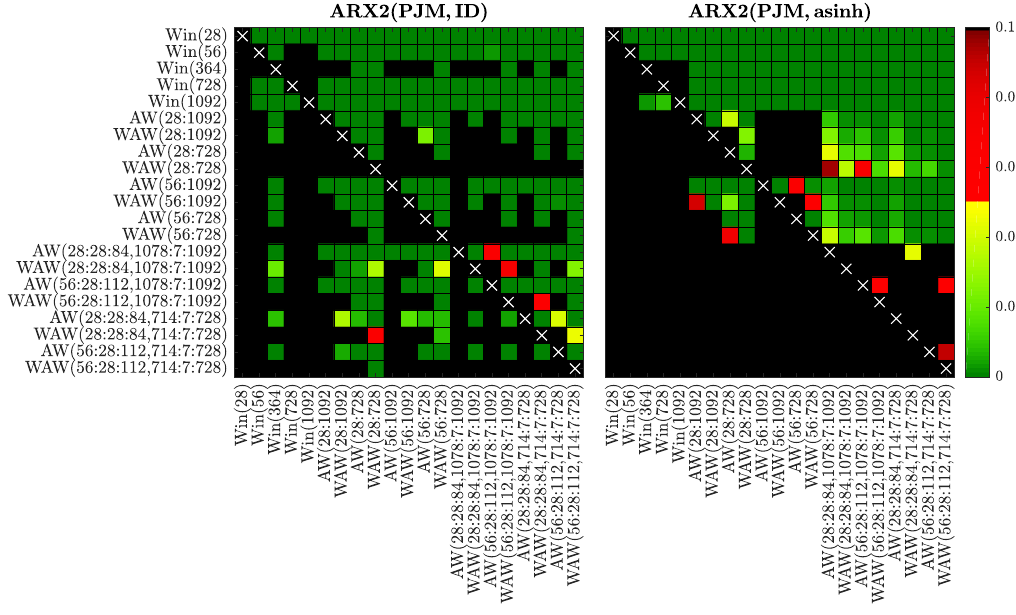
Figure 11. Results of the CPA test for selected window sets and the ARX2 model fitted to raw ( left ) or asinh -transformed ( right ) PJM data. We use a heat map to indicate the range of the p -values—the closer they are to zero ( → dark green) the more significant is the difference between the forecasts of a set on the X -axis (better) and the forecasts of a set on the Y -axis